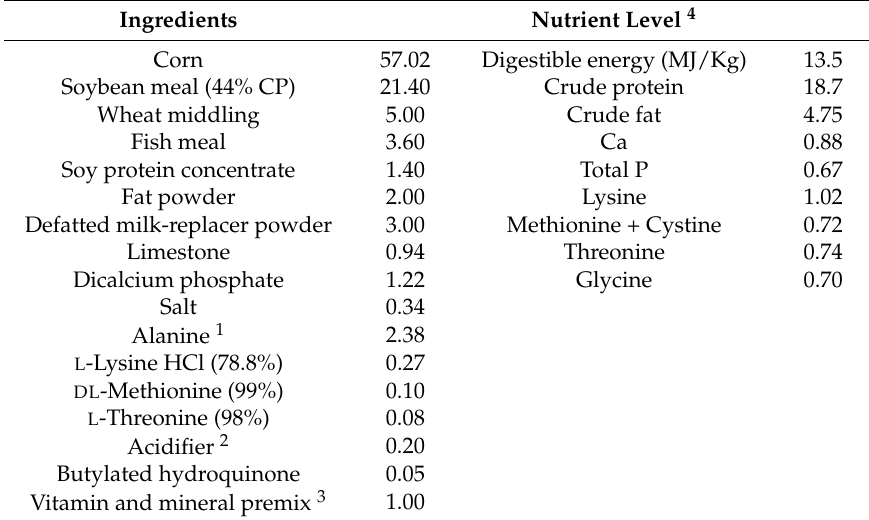
Table 7. Ingredient composition of experimental diets (%, as-fed